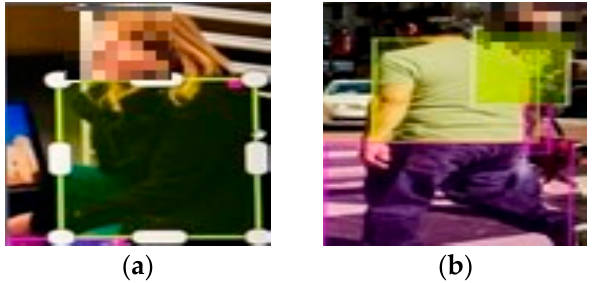
Figure A4. In ( a ) and ( b ), there is a false positive Bbox in the right corner of the shirt. 5. Shirt class includes any clothes on the upper body (blazer, short dress, T-shirt, blouse); trouser includes shorts too.